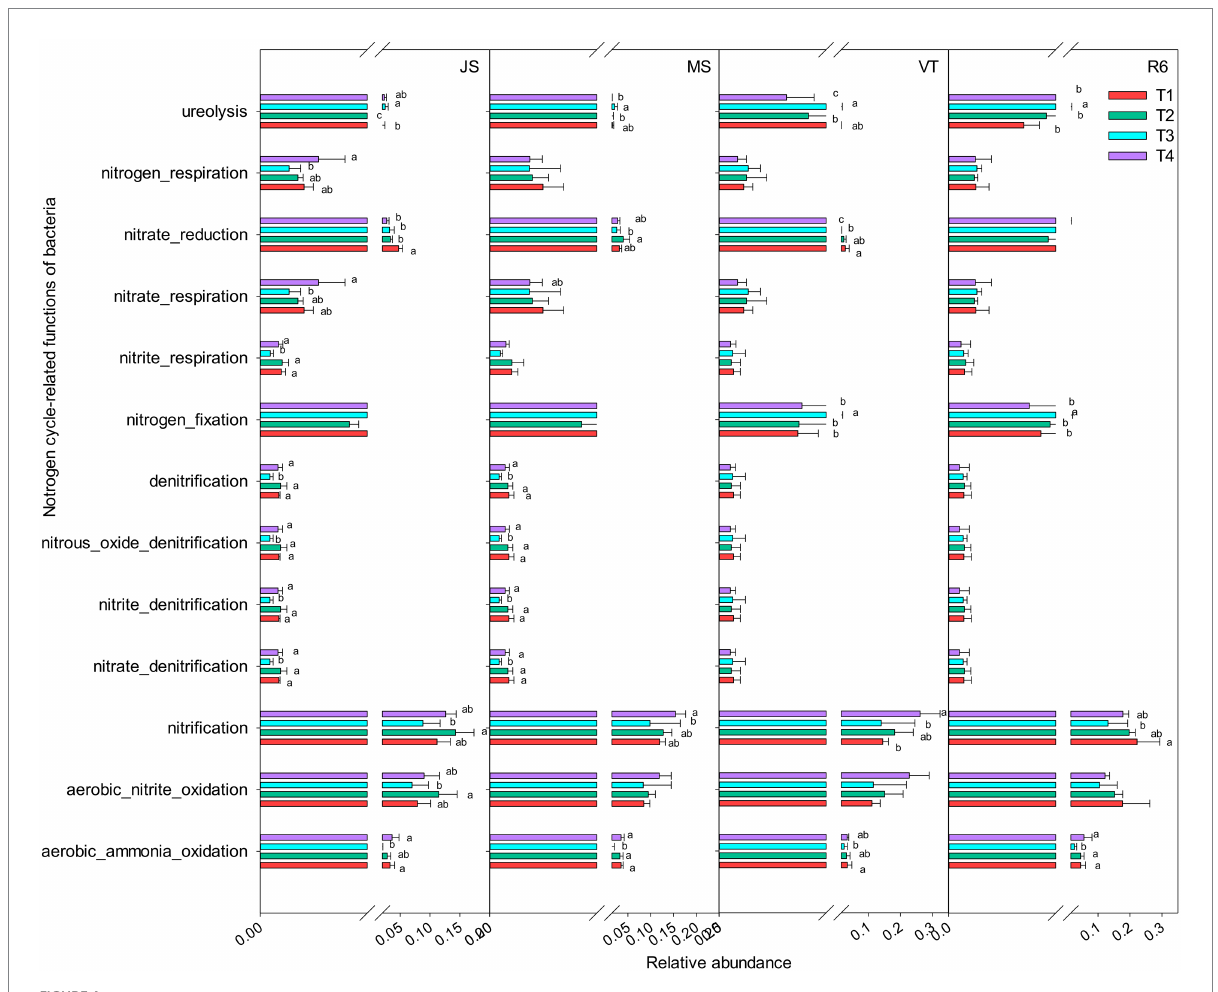
FIGURE 4 Nitrogen cycle-related functions of the bacterial communities as predicted by FAPROTAX. Different letters represent significant differences ( p < 0.05). JS, jointing stage of wheat; MS, maturity stage of wheat; VT, tasseling stage of maize; R6, maturity stage of